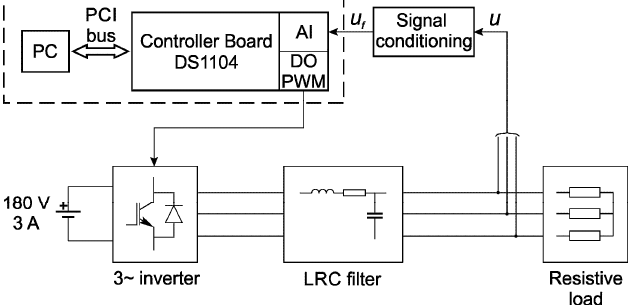
Figure 1. Block diagram of the three-phase voltage generator.